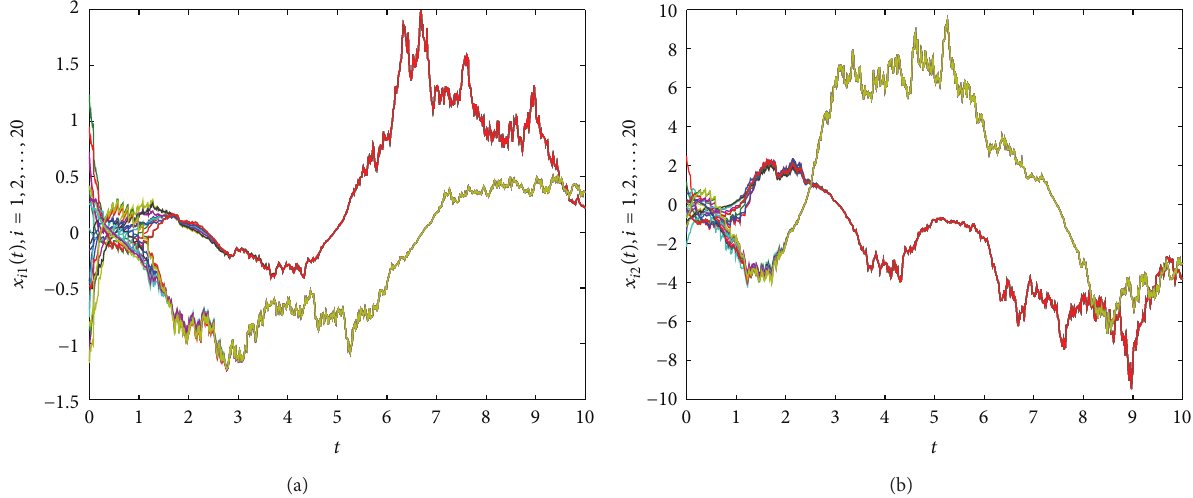
Figure 2: (a) The trajectories of the state variables of 𝑥 𝑖1 (𝑖 = 1,2,...,10) in system (41) under pinning control; (b) The trajectories of the state variables of 𝑥 𝑖2 (𝑖 = 1,2,...,10) in system (41) under pinning